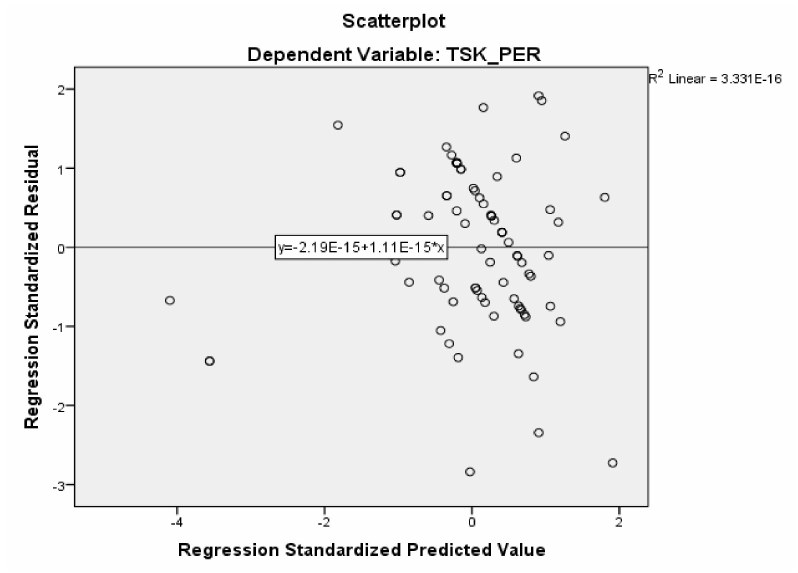
Figure 9. Dependent variable versus Regression standardized residual.